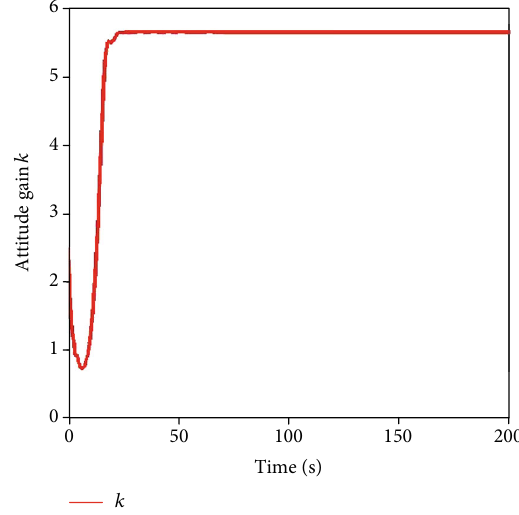
Figure 12: Time histories of attitude gain k ð t Þ in Case